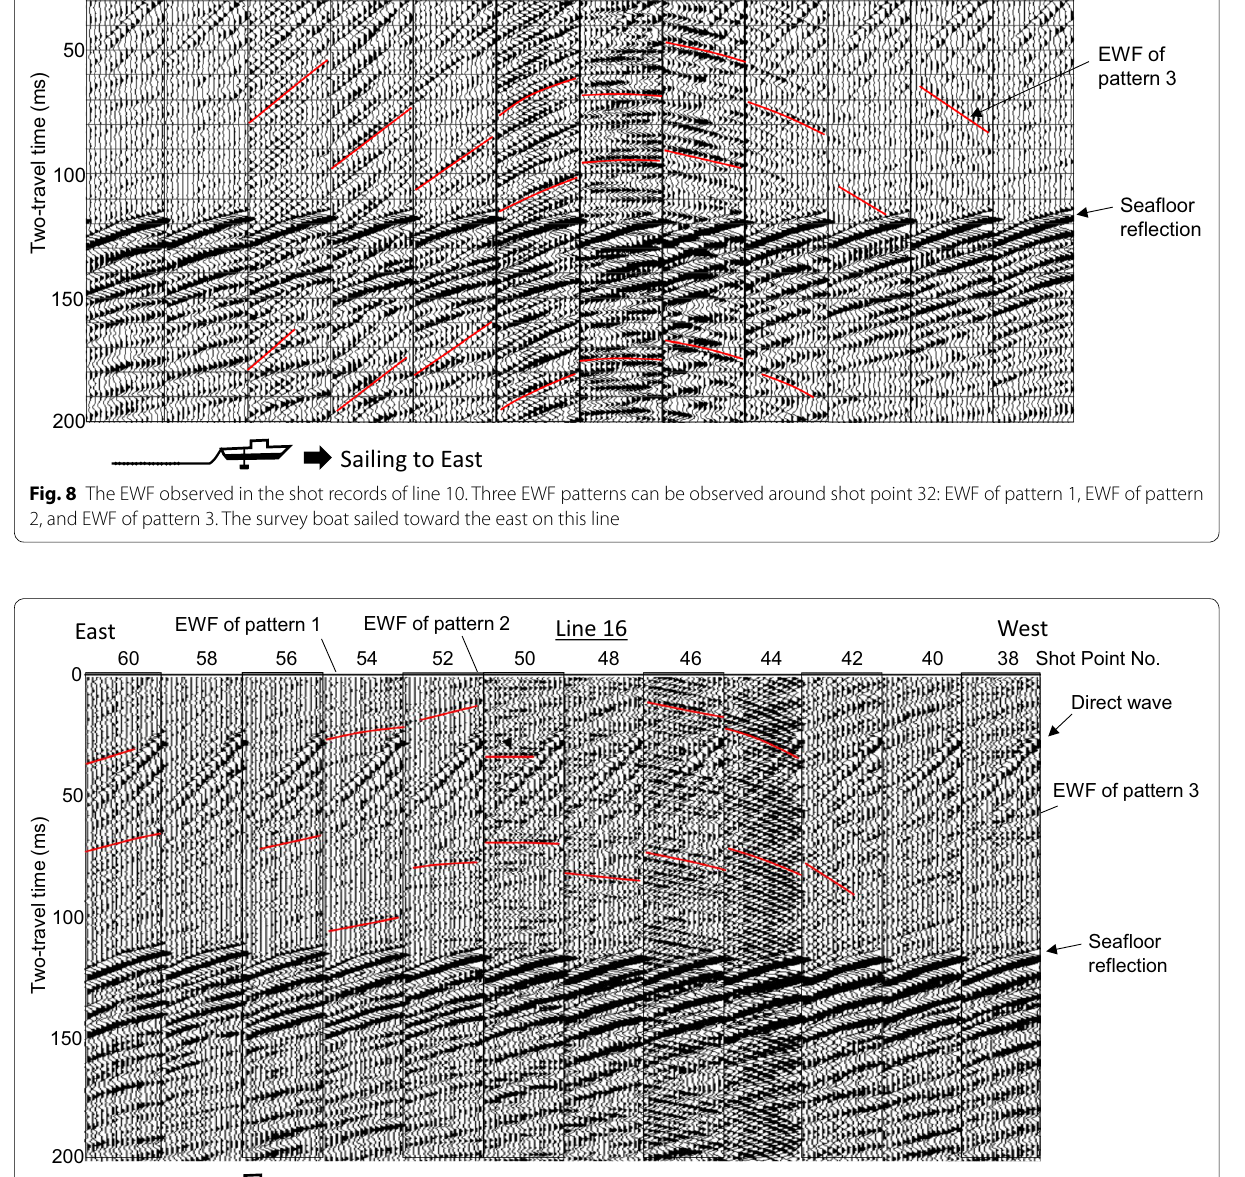
located near the ends of these faults, where the seafloor displacements of these faults are relatively small or zero.